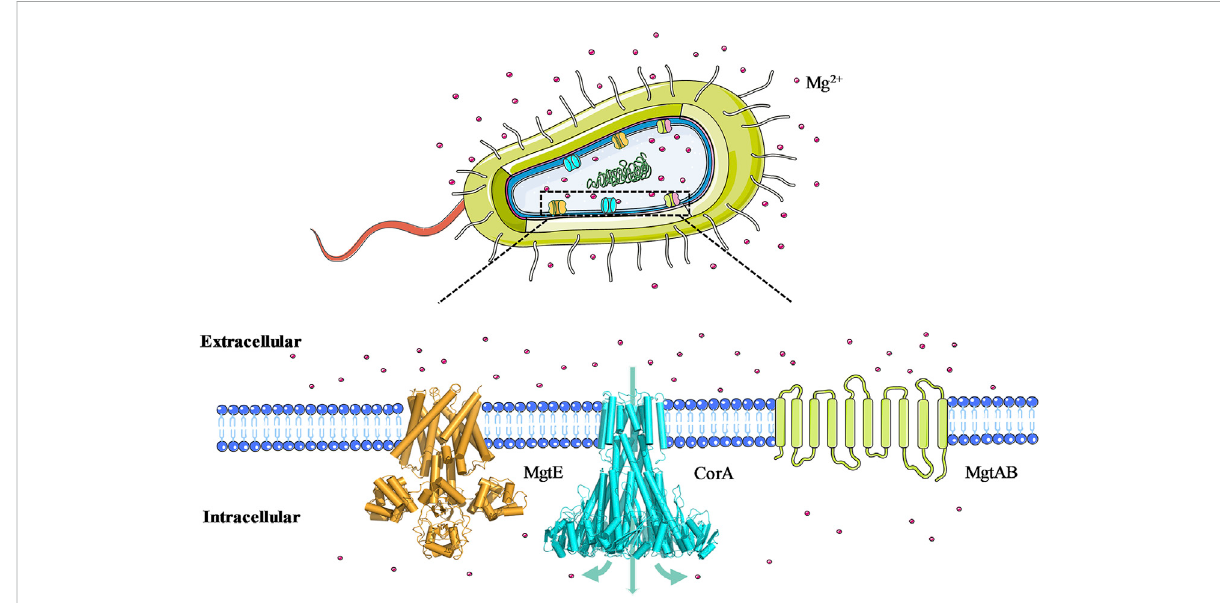
FIGURE 1 Schematic representation of three prokaryotic Mg 2+ transporter classes. MgtE is a homodimer in which the cytoplasmic portion of each monomer consists of an N domain, a tandemly repeated cystathionine β -Synthase domain. CorA is a homo-pentamer in which each monomer contains a large N-terminal cytoplasmic domain and two transmembrane helices. MgtA is a monomeric P-type ATPase, and its three-dimensional structure has not yet been